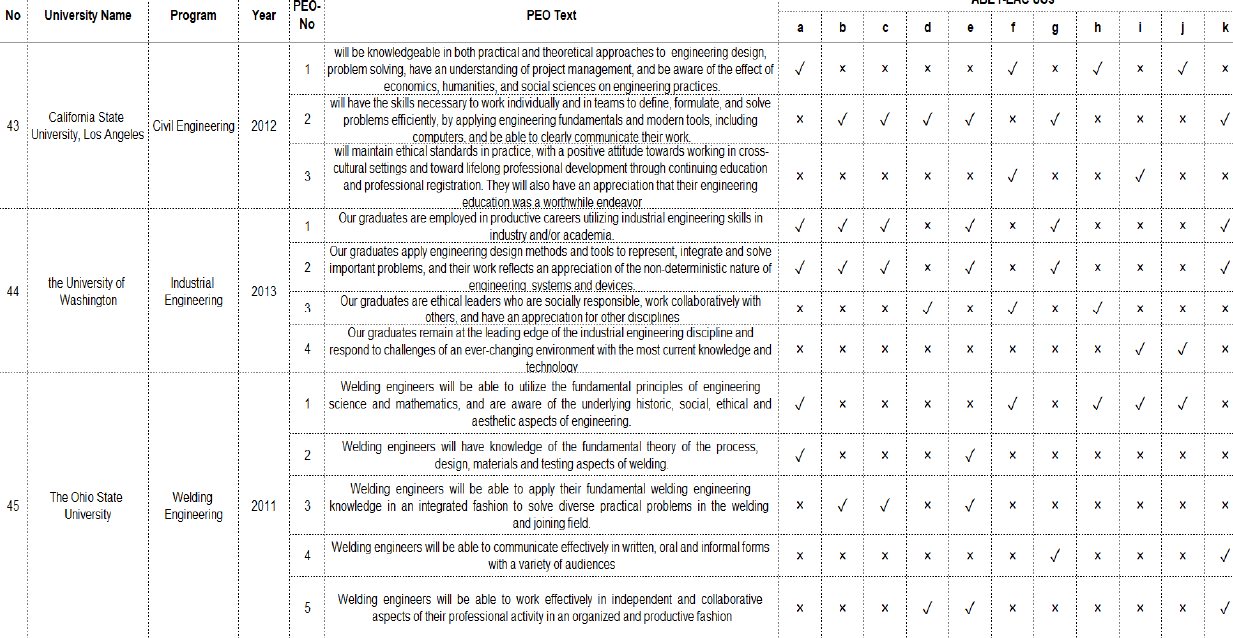
Table 1. PEOs Label